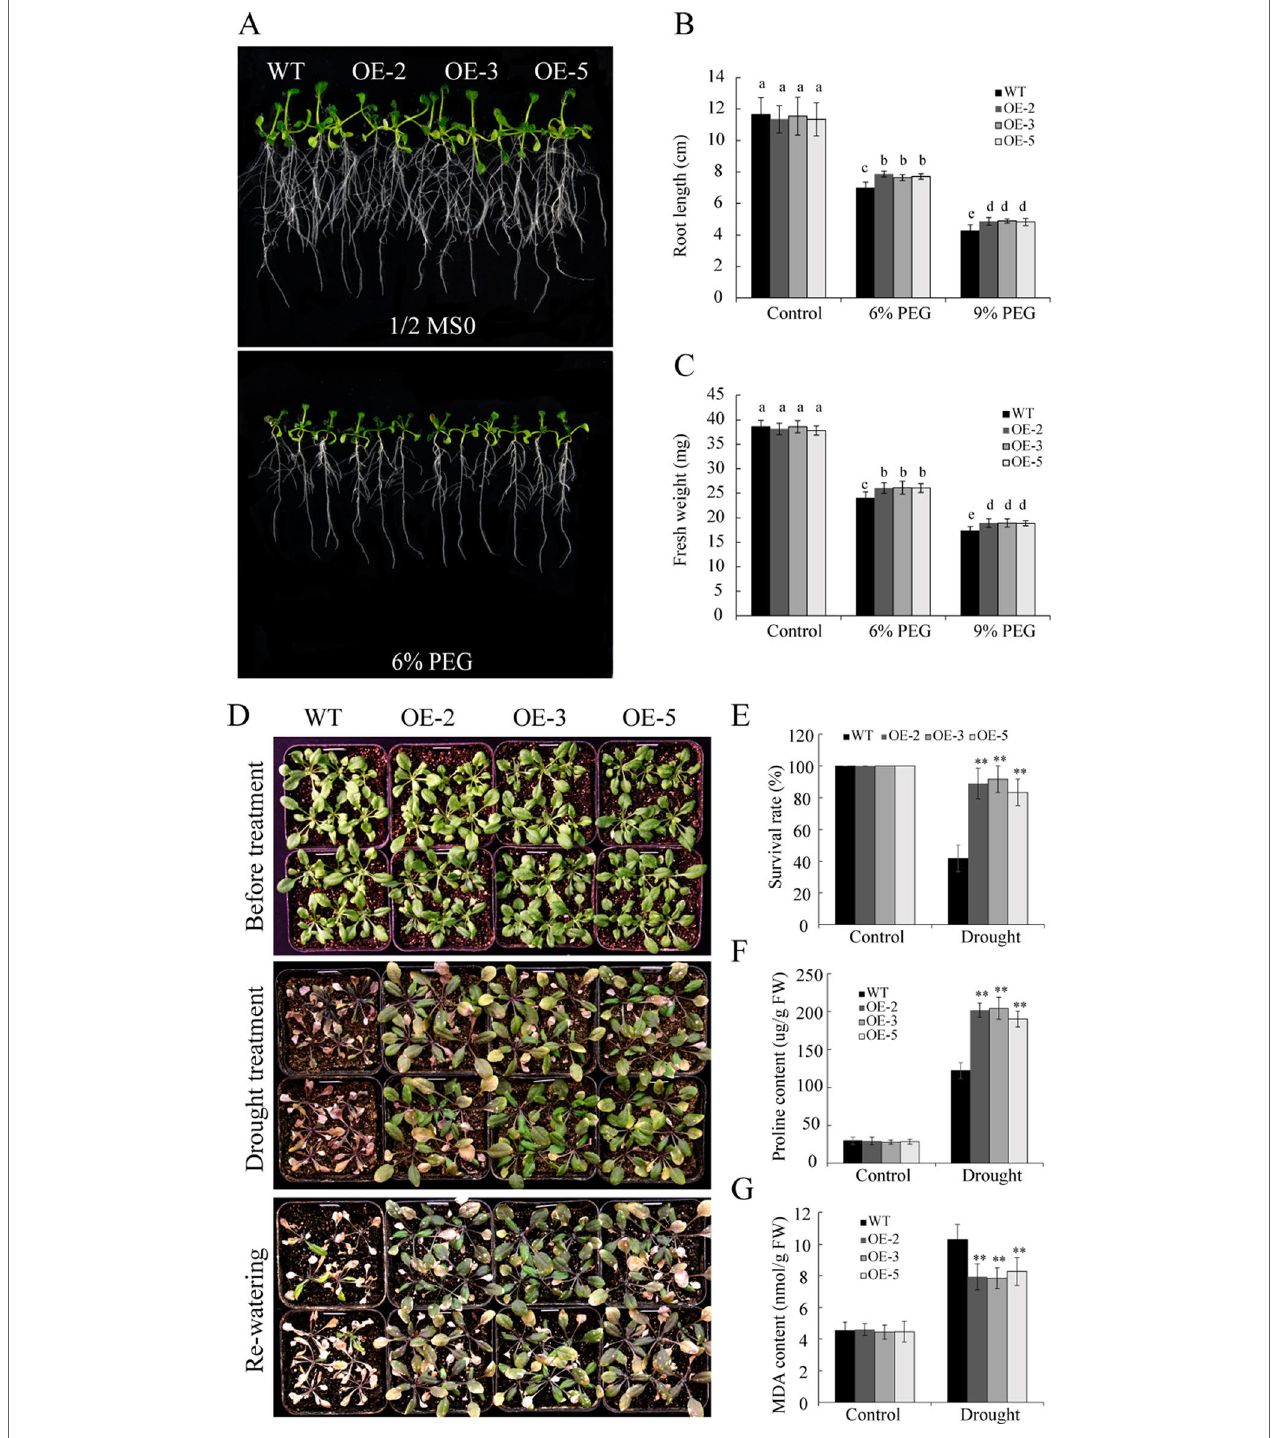
FiGURe 10 | Overexpression of GmSAP16 enhances drought tolerance in Arabidopsis . (A) Root length assays of wild-type (WT) and GmSAP16 -overexpressing plants under normal conditions and polyethylene glycol (PEG) treatment. Five-day-old seedlings of WT and GmSAP16 -overexpressing lines were transferred to 1/2 Murashige and Skoog (MS) medium with different concentrations of PEG (0, 6%, and 9%) for root length assays. At least 20 seedlings were measured for (B) main root length and (c) fresh weight. (D) Drought tolerance phenotypes of WT and GmSAP16 transgenic Arabidopsis in soil. Three-week-old seedlings of WT and GmSAP16 -overexpressing lines were dehydrated for 2 weeks and then rehydrated for 3 days. Statistical analysis of the survival rates (e) , proline content (F) , and MDA content (G) . Data are presented as the mean ± SD of three independent replicates. The asterisks indicate significant differences between WT and GmSAP16 - overexpressing lines (**, P 0.01; Student’s t test). Different letters indicate significant differences within treatments by ANOVA (P 0.05).